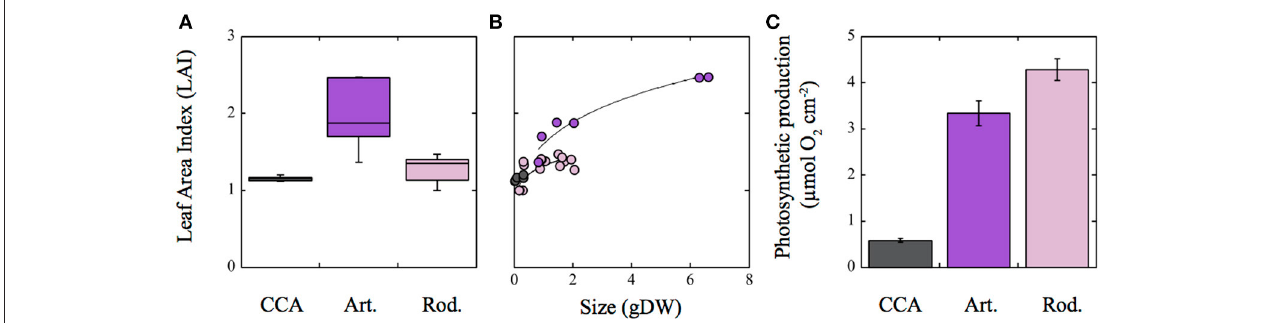
FIGURE 6 | Variation of the Leaf Area Index (LAI) in the three growth-forms of coralline algae characterized in this study. (A) Box plot describing LAI variability for each coralline growth-form; (B) variation of LAI as a function of coralline algal size in g DW; (C) estimated photosynthetic production for each coralline growth-form for 1 h assuming a constant P max ( µ mol 0 2 cm − 2 ). Photosynthetic data were derived from Vásquez-Elizondo and Enríquez (2016). For (A) : Boxes encompass the 25 and 75% quartiles of all data, the central horizontal line represents the median, bars extend to the 95% confidence limits, and open circles represent observations extending beyond the 95% confidence limits. Solid lines in (B) correspond to a power function fit [y = a * x b ]. Colors denote: pink for the rhodolith Neogoniolithon sp.; purple for the articulated alga Amphiroa tribulus; and gray for the crustose coralline (CCA) Lithothamnion sp. Error bars in (C) correspond to SE ( n = 6).